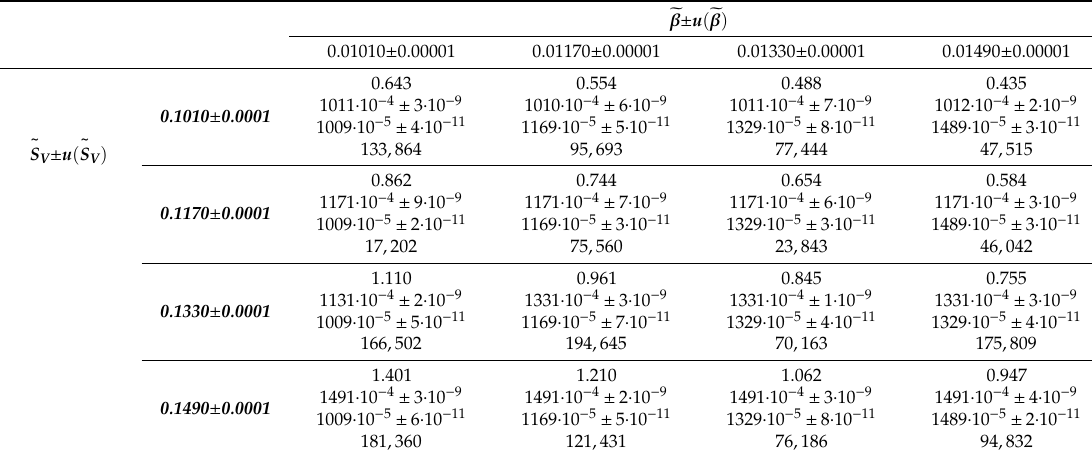
Table 4. Results of MC